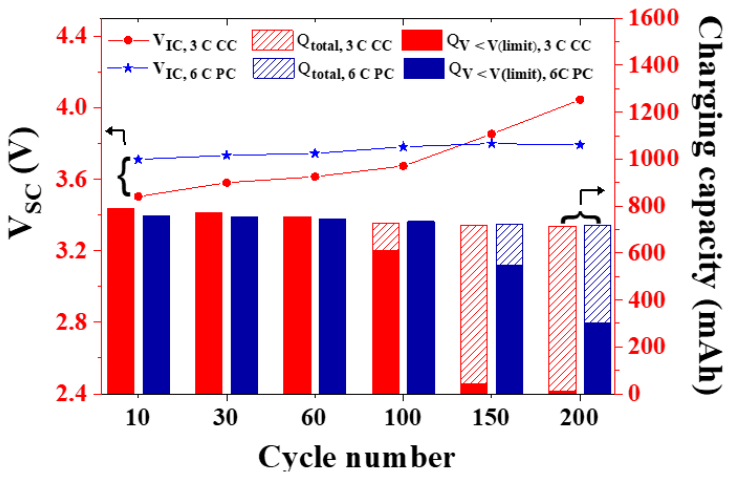
Figure 5. Charging start voltage and capacity in accordance with charging methods.